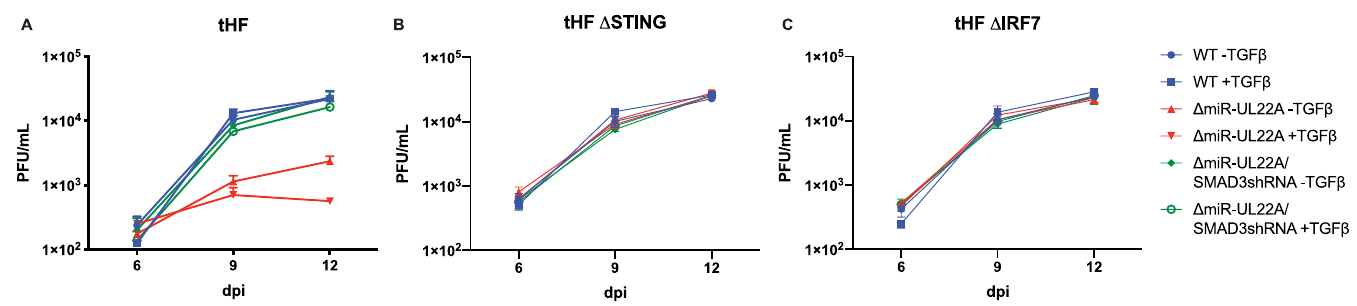
Fig 8. TGF β impairs lytic replication in coordination with IRF7. tHF (A), Δ STING (B) or Δ IRF7 (C) tHFs were infected at 0.01 PFU/mL. TGF β was added (100pg/mL) after initial infection and again at days 6 and 9. Supernatants were harvested and titered in NHDF. Experiments were performed in duplicate.